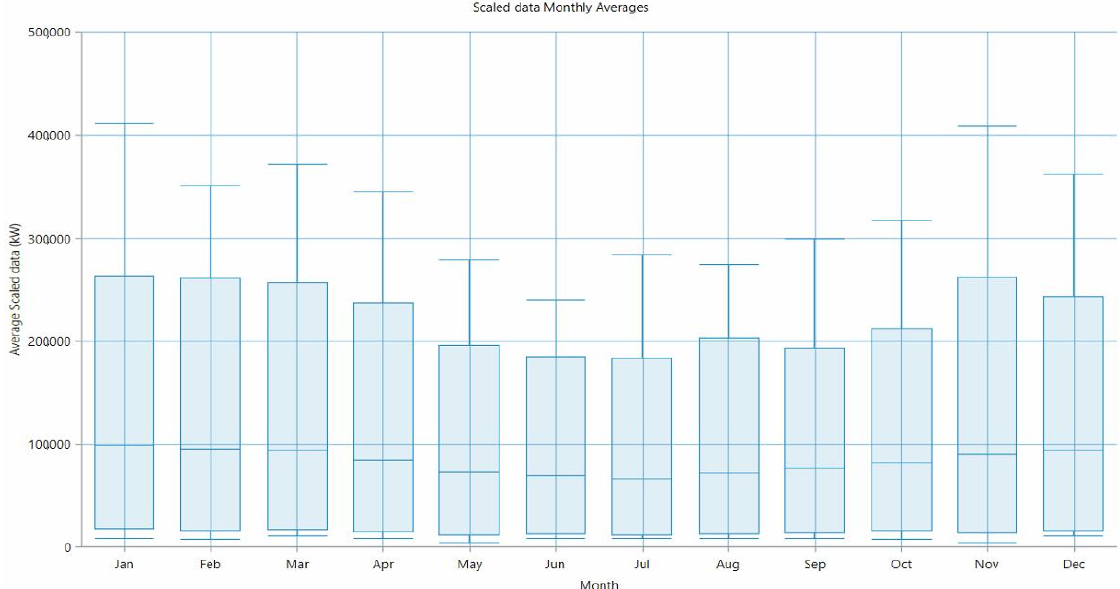
Figure 4. Seasonal profile of energy usage based on the input data from [24].